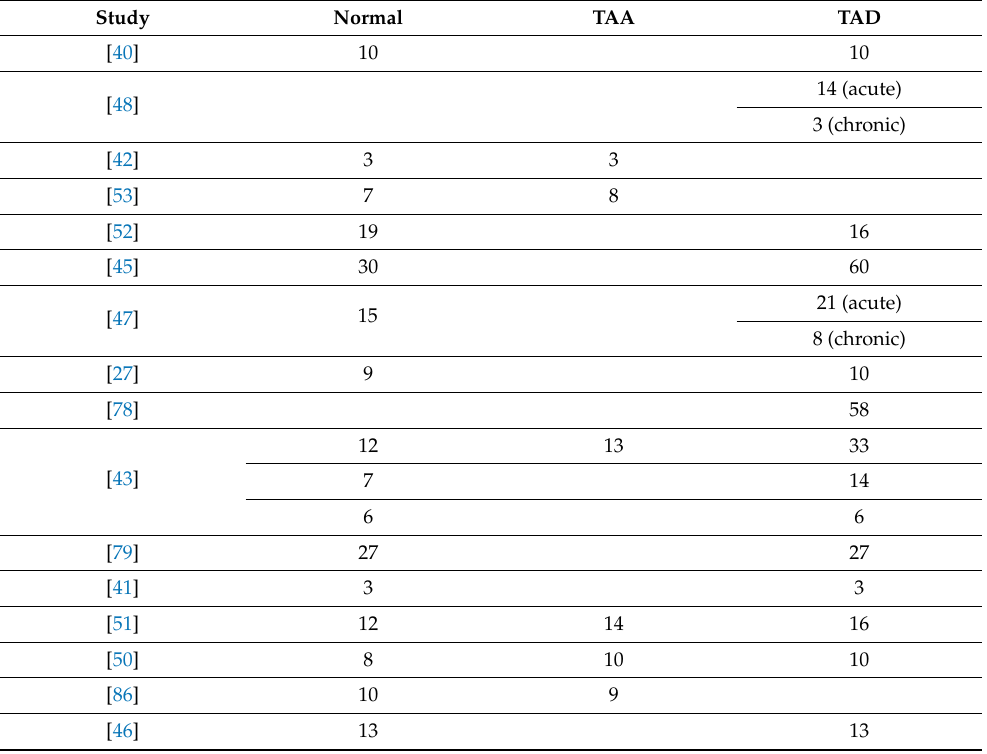
Table 5. Patient numbers in TAA and TAD